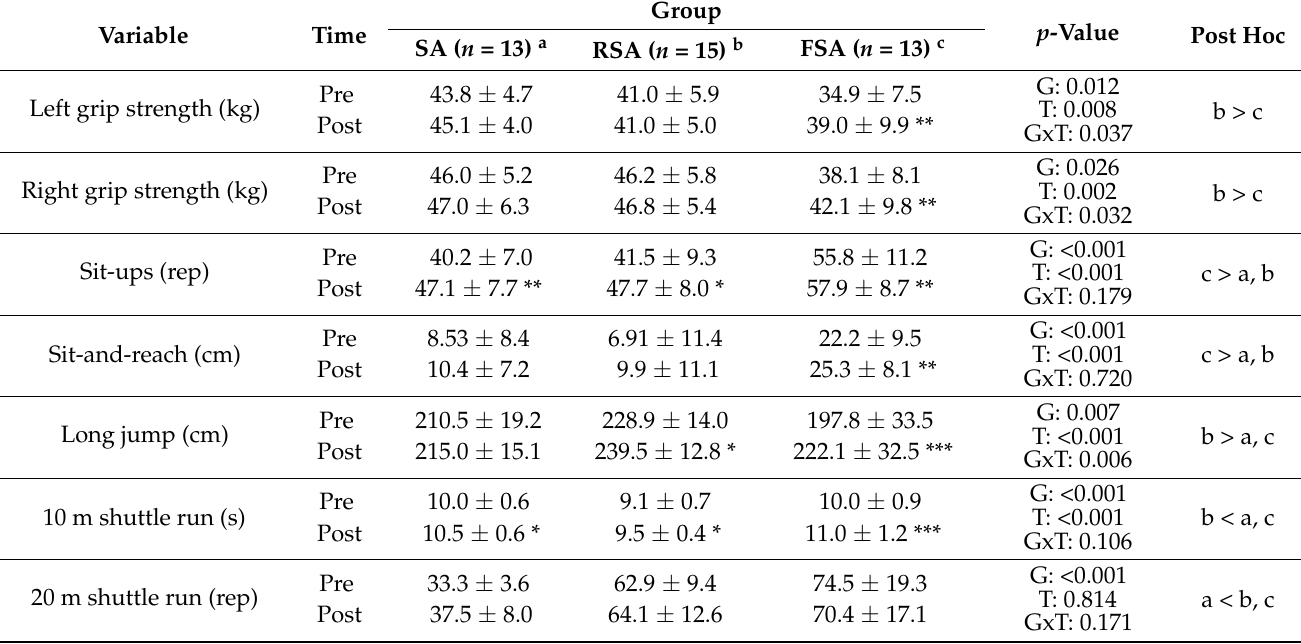
Table 2. Measurements of physical fitness parameters by group and